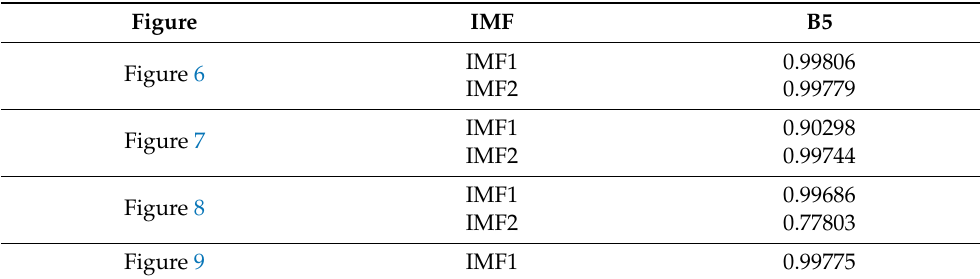
Table 2. Correlation coefficient between the component signal and capacity.